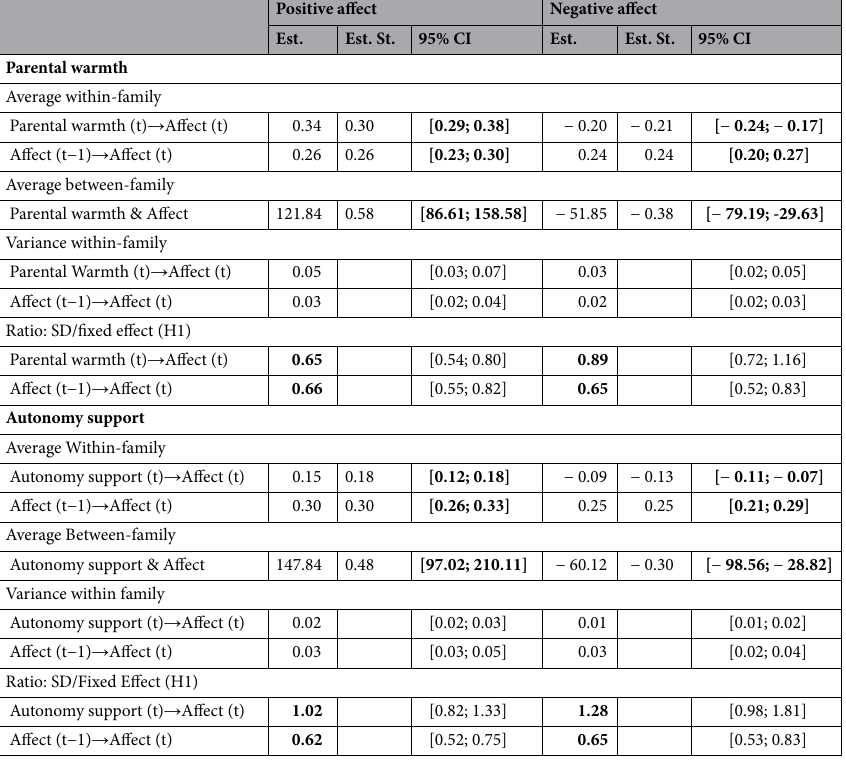
Table 2. Model results of dynamic structure equation models (child reported need-supportive parenting). Bold values indicate significant/meaningful estimates. Est., unstandardized estimates; Est. St., standardized estimates for fixed within- and between-family effects, standardized using the STDYX Standardization (Within-Level Standardized Estimates Averaged over Clusters) in M plus ; Ratio, Random Slope SD/Fixed Effect: a point estimate > 0.25 is the criterium we defined as meaningful effect heterogeneity 31 ; 95% CI, 95% Credibility